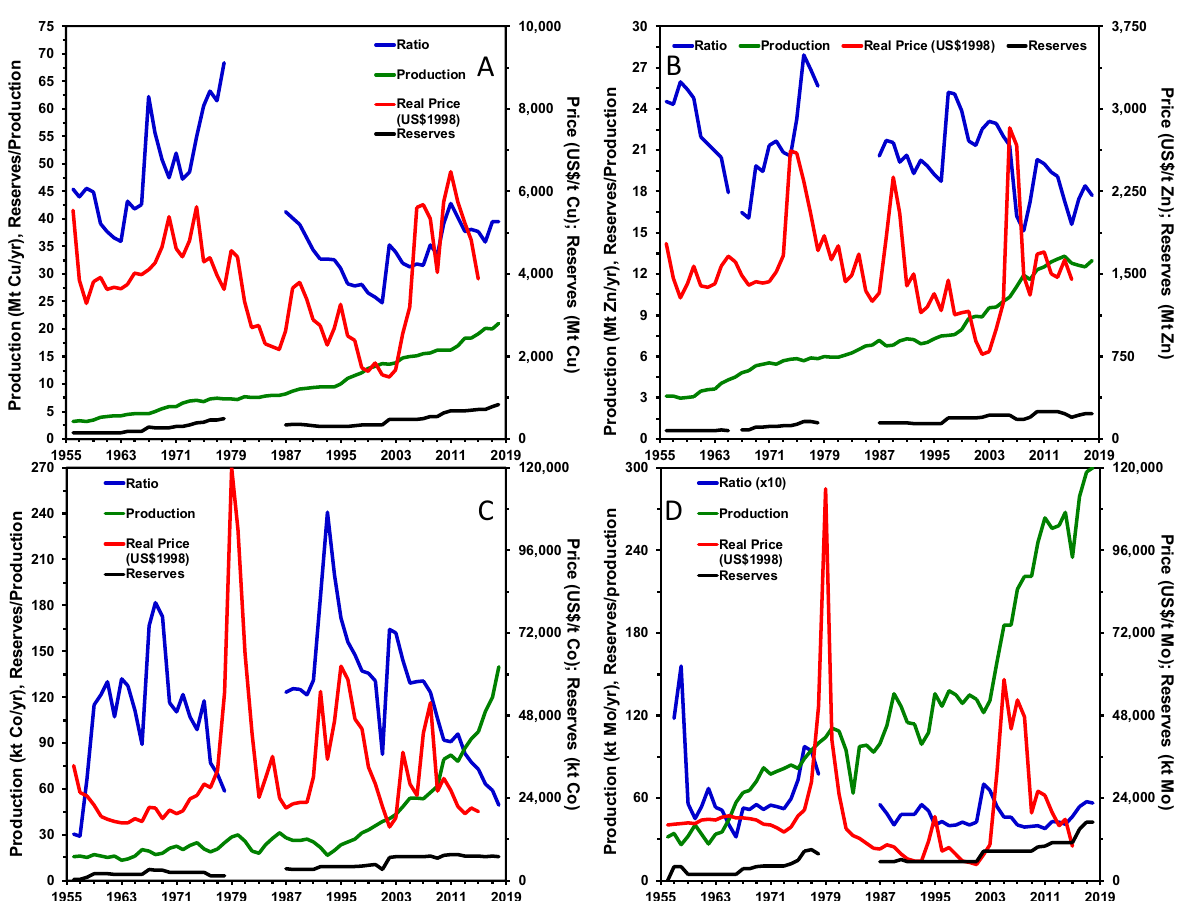
Fig. 3 Production, reserve, reserve/production ratio and price data 27 – 29 for selected metals from 1956 to 2018. Data are shown for Cu ( a ), Zn ( b ), Co ( c ) and Mo ( d